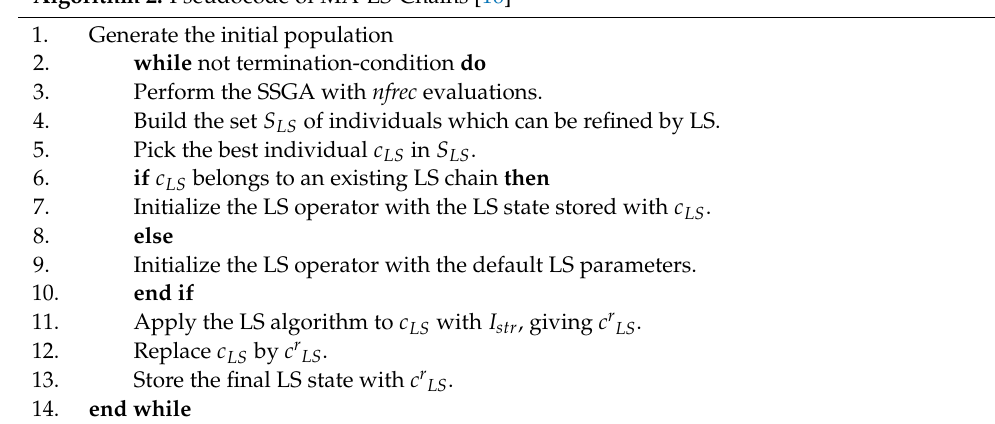
Algorithm 2. Pseudocode of MA-LS-Chains